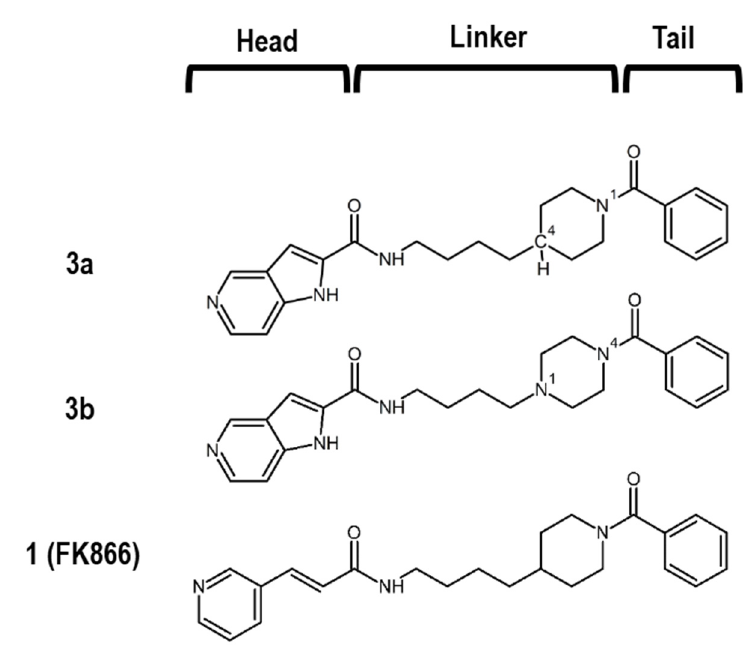
Figure 2. Chemical structures of 3a , 3b and 1 .